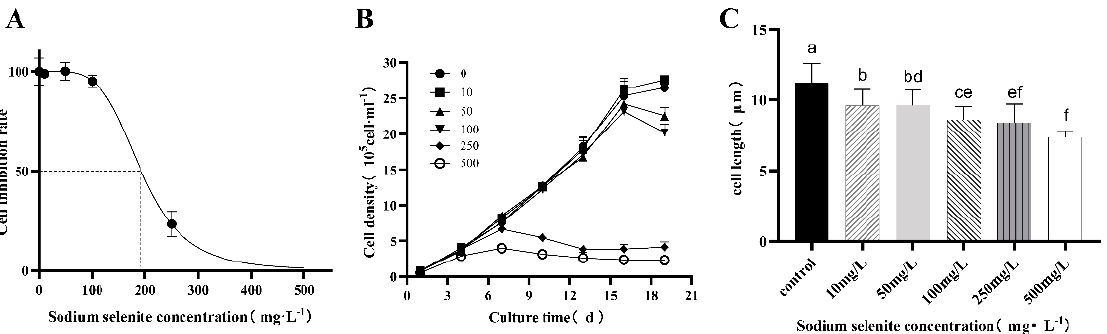
Figure 1. Effect of different concentrations of selenite on the growth of D. salina . ( A ) Dose-response curve of the different selenite concentrations according to the final cell concentration reached after 11 days. ( B ) Effect of different concentrations of selenite on the growth curves of D. salina . ( C ) Size of D. salina cells at different selenite concentrations. Different low case letters above columns indicate statistical differences at p < 0.05